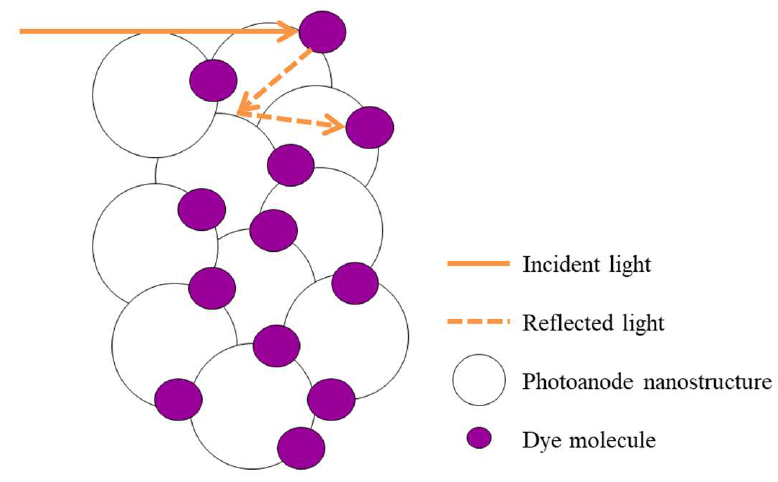
Figure 8. Light scattering effect on large particle size semiconductor photoanode material. The electrical performance of DSSCs using various natural fruit dyes containing anthocyanin pigments is summarized in Table 2. The highest energy conversion efficiency for natural dye-based DSSC is found in the ZnO photoanode-based device with black grape dye (3.63%). We can observe that for all organic dyes, most ZnO-based DSSC was reported to give higher V oc than TiO 2 -based DSSC. These findings are consistent with the hypothesis that materials with higher bandgap values have higher V oc values, as in Equation (6) [26], which may be associated with slower recombination and better electron collection. This argument is backed by the characteristics of ZnO material, which is known to have better electron mobility than TiO 2 material, which further enhances electron transport and makes charge carrier separation easier. Different organic dyes used do not seem to affect V oc significantly, but different photoanodes do.